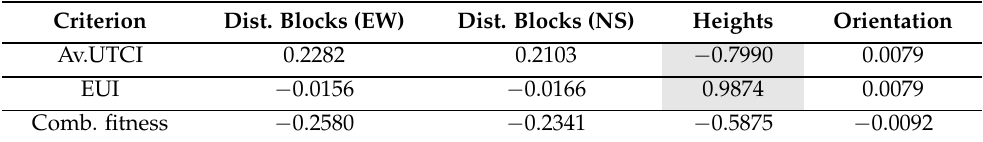
Table 3. Correlation coefficients (R) between design parameters and performance criteria. The strongest correlations are highlighted.